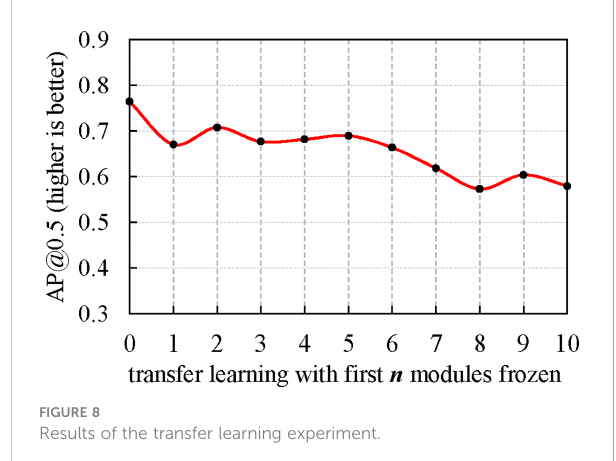
FIGURE 8 Results of the transfer learning experiment.